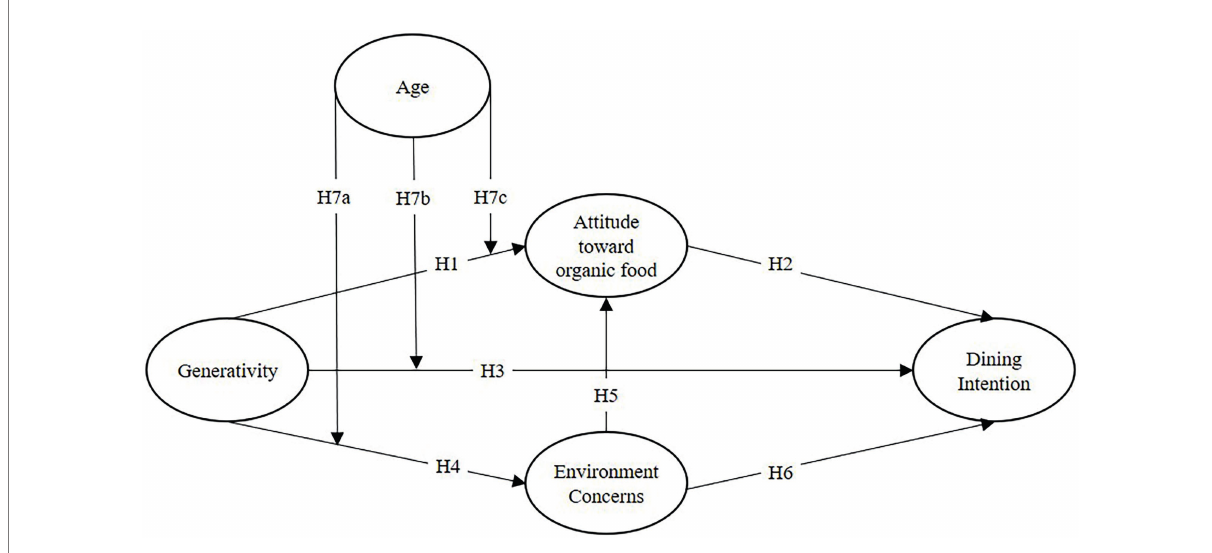
FIGURE 1 Research